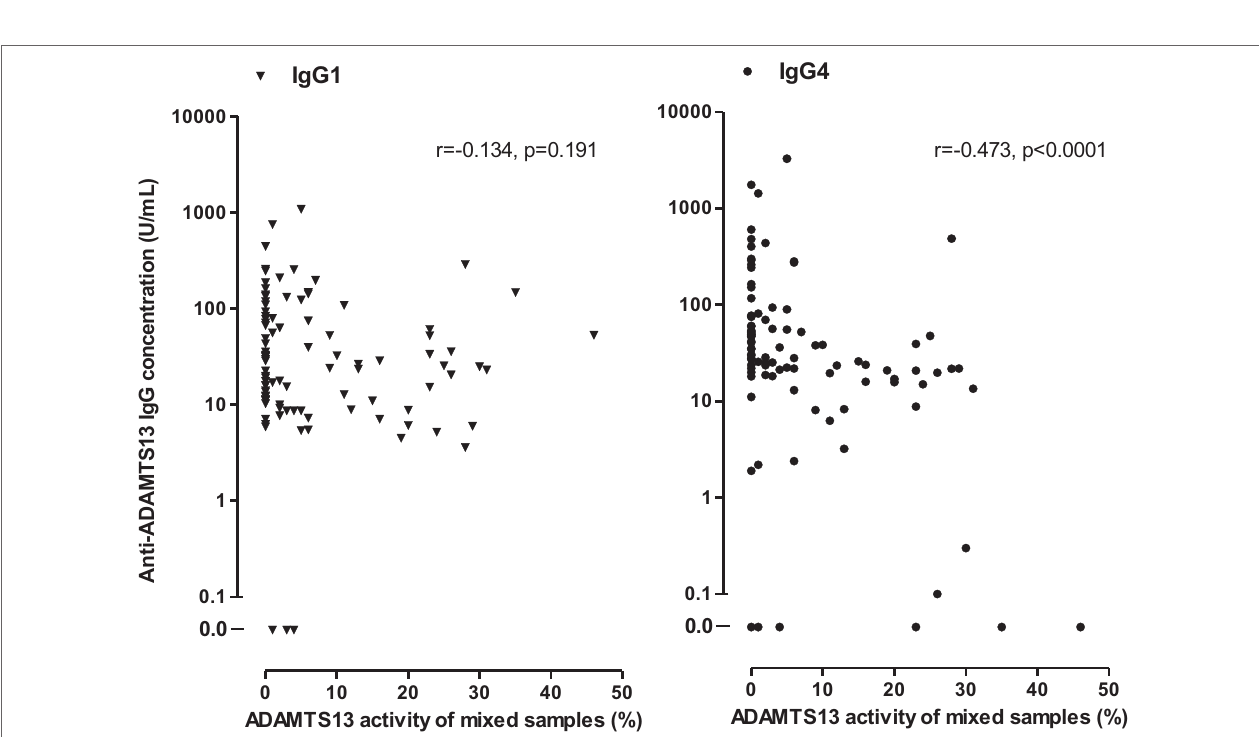
FigUre 4 | Dominant subclasses in samples of patients with multiple samples. Dashed arrows show a change in the dominant subclass, arrows indicating a change from IgG1 to IgG4 appear in bold. The only sample with normal ADAMTS13 activity (with low positive levels of anti-ADAMTS13 antibodies) is marked by an asterisk.